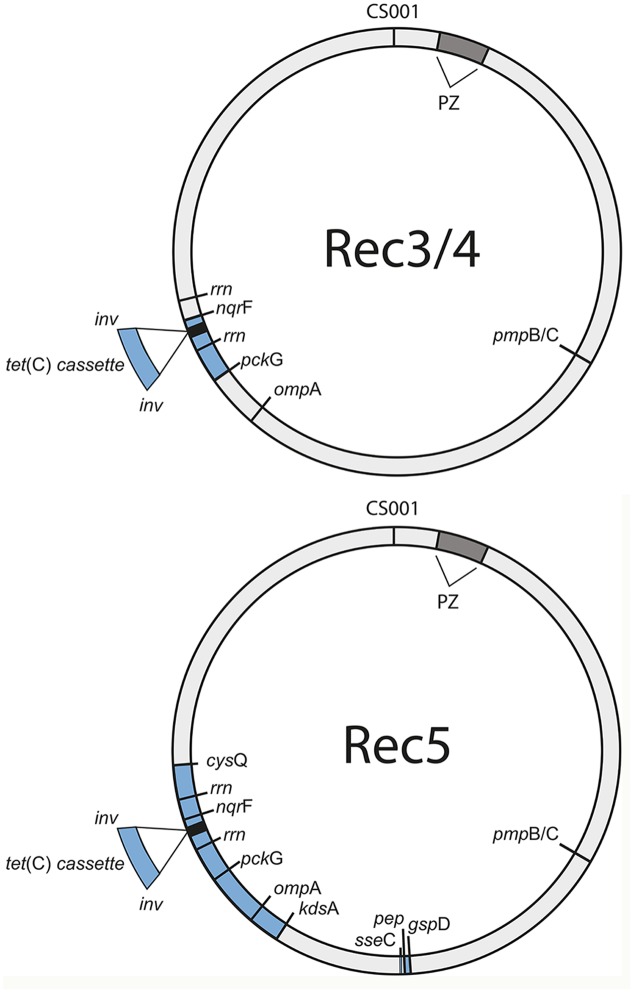
Tet(C)-cassette insertions in the S45 genome are heterogeneous. Shown are the sites of insertion (blue) for the three confirmed recombinants, Rec 3/4 (top) and Rec 5 (bottom), in the circular S45 genome. PZ, plasticity zone (dark gray); cysQ, adenosine-3′(2′),5′-bisphosphate nucleotidase; rrn, rrn operon (16S rRNA, 23S rRNA, 5S rRNA); nqrF, Na(+)-translocating NADH-quinone reductase subunit F; pckG, phosphoenolpyruvate carboxykinase [GTP]; ompA, major outer membrane protein A; kdsA, 2-dehydro-3-deoxyphosphooctonate aldolase; gspD, Putative general secretion pathway protein D; hp, hypothetical protein.